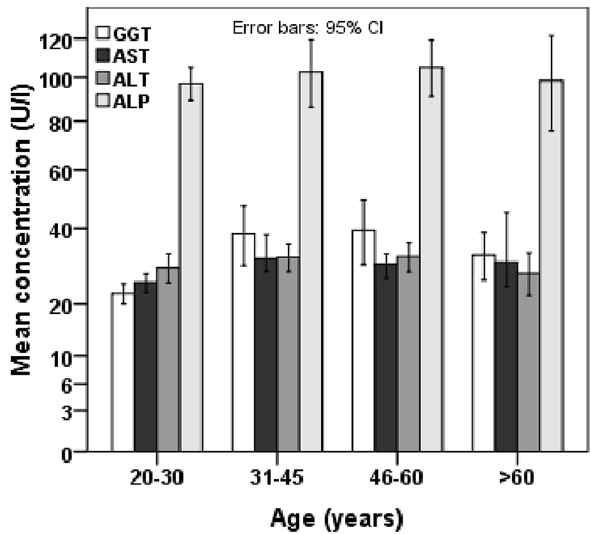
Figure 3. Levels of serum liver enzymes in the different age groups (n = 210 in 20–30 years, n = 134 in 31–45 years, n = 134 in 46–60 years and n = 62 in > 60 years group). The levels of liver enzymes in the age groups are compared by one way